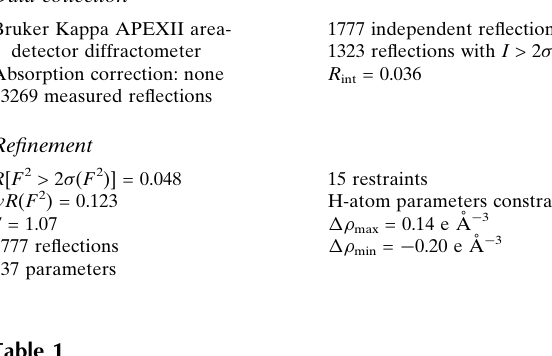
Hydrogen-bond geometry (A˚ , (cid:4)